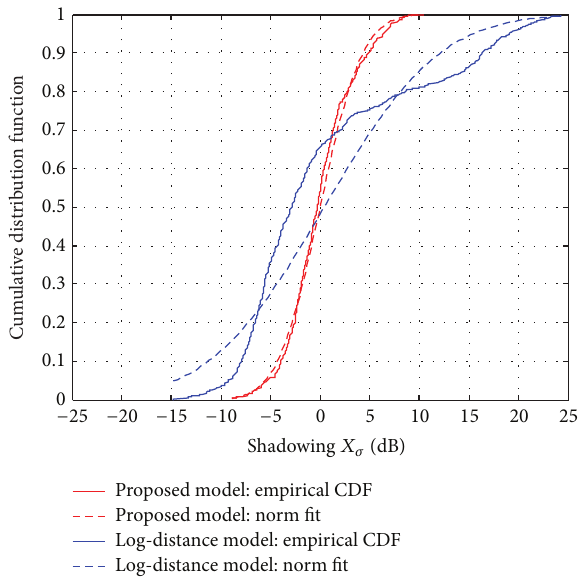
Figure 5: CDFs of overall shadowing of the proposed model and log-distance model.